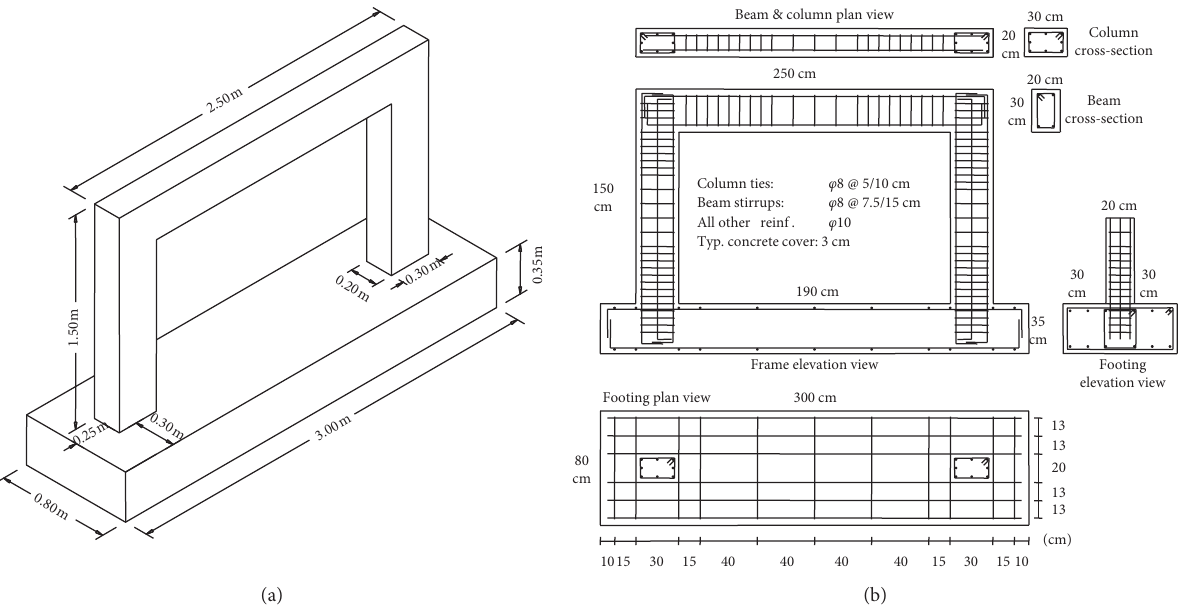
Figure 2: (a) Geometric and (b) reinforcement details of the RC test frame.